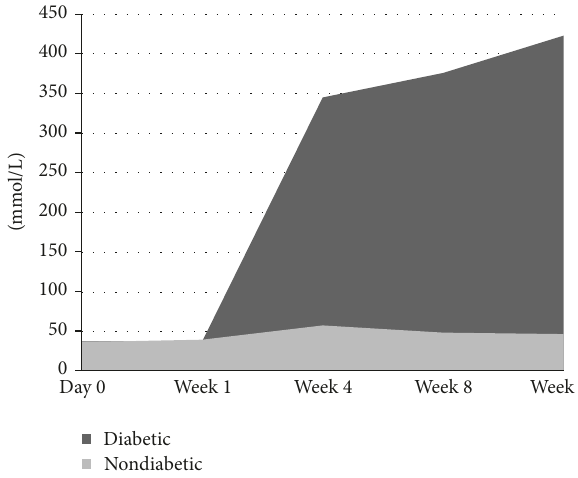
Figure 1: Glucose levels (mmol/L) in STZ treated and nontreated controls. There is a significant increase in the glucose levels in diabetic animals when compared to healthy